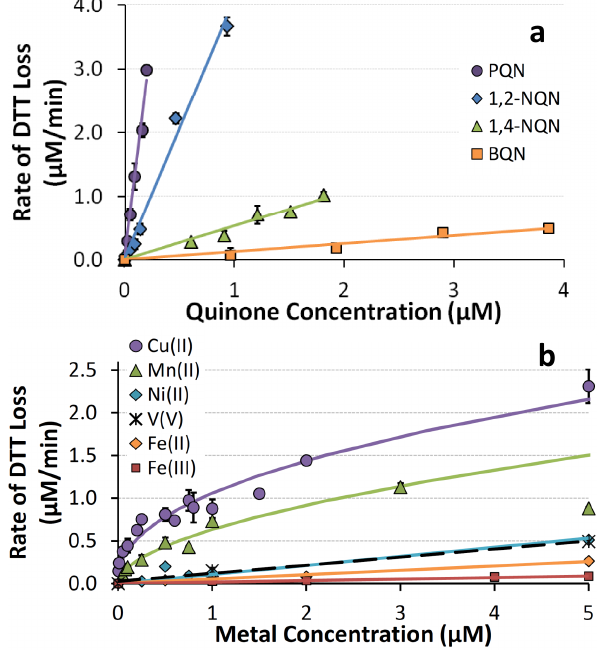
Fig. 4. Blank-corrected rates of DTT loss as a function of concentra- tion of redox-active species. (a) shows results for the four quinones that oxidized DTT, while (b) shows results for the six DTT-reactive metals. Each point represents the average (± σ ) of multiple individ- ual rate determinations. Lines represent regression fits to the exper- imental data; the corresponding equations are listed in Table 1. The regression for Mn(II) does not include the 5.0µM